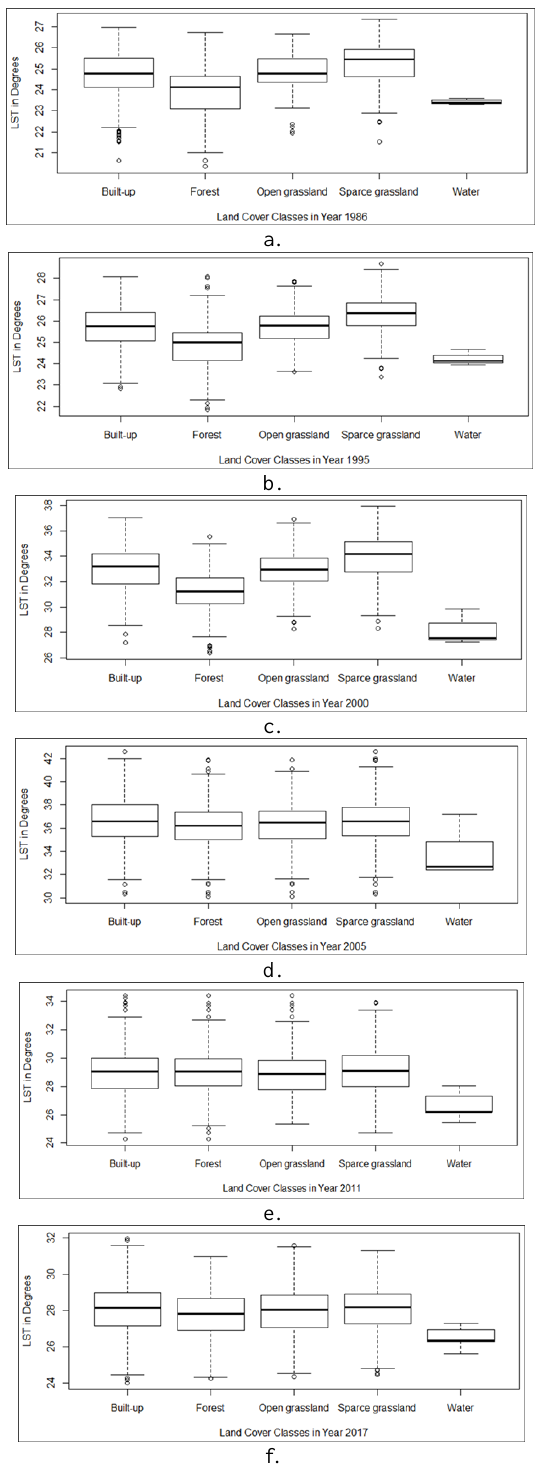
Figure 7: Mean afternoon and night LST of land cover In the afternoon, forests LST was slightly higher than built-up, which had the lowest LST in 2005 and 2011, while in 2017, forest LC had the lowest LST at 40.37 0 C. At night, forest land cover had higher LST than built-up, open and closed grassland. Forests